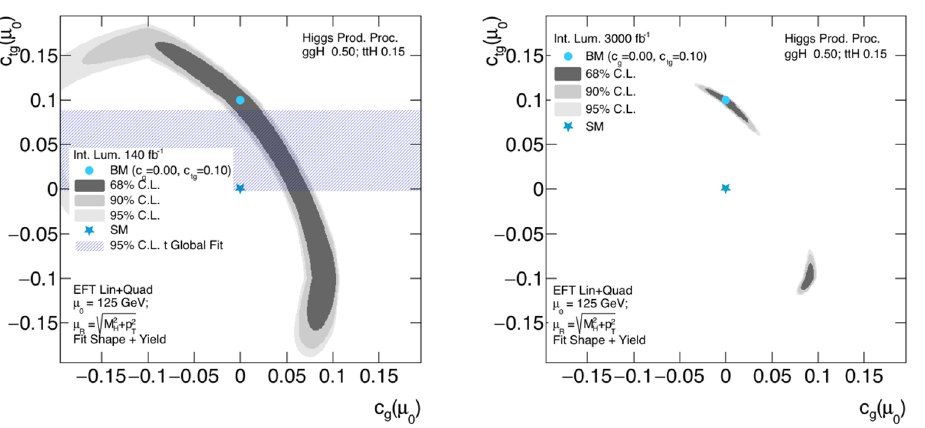
Figure 12. Constraints on the c g and c tg coefficients at 68% (dark grey), 90% (mid grey) and 95% (light grey) C.L. obtained from the fit including ggF (0.50) and t ¯ tH (0.15) SMEFT contributions to the spectrum shape and Higgs signal rate on 200 < p H < 2000 GeV with 140 fb − 1 (left panel) and T 3000 fb − 1 (right panel) for a benchmark point with c g ( µ 0 ) = 0 and c tg ( µ 0 ) = 0 . 1 . The benchmark value is indicated by the dark blue circle. The shaded horizontal strip indicates the 95% C.L.